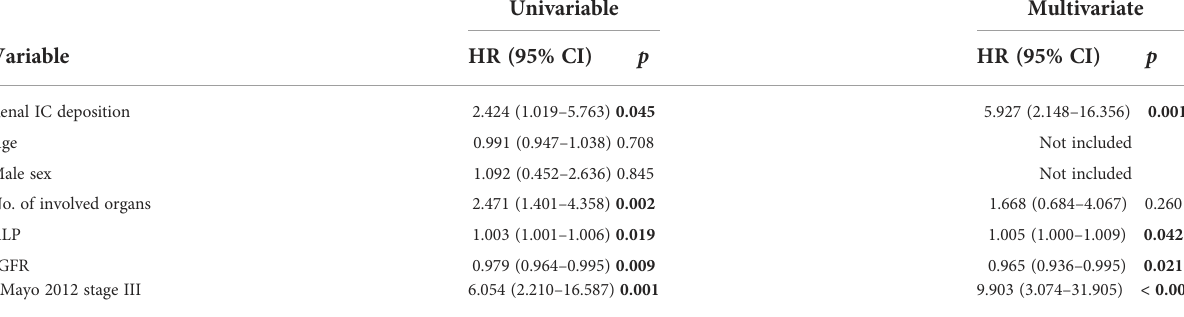
TABLE 4 Univariate and multivariate Cox regression analyses for overall survival in the study cohort. Univariable Multivariate